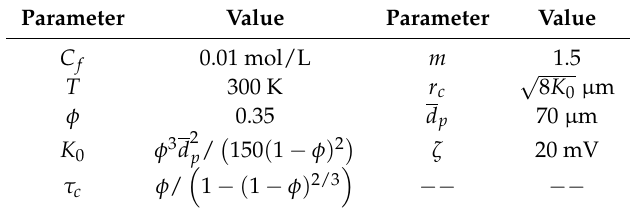
Figure 8. The frequency dependence of streaming potential coupling coefficient (SPC) estimated by different models: ( a ) the amplitude of SPC; ( b ) the phase of SPC. Table 3. The parameters used in modeling C sp with different methods in Figure